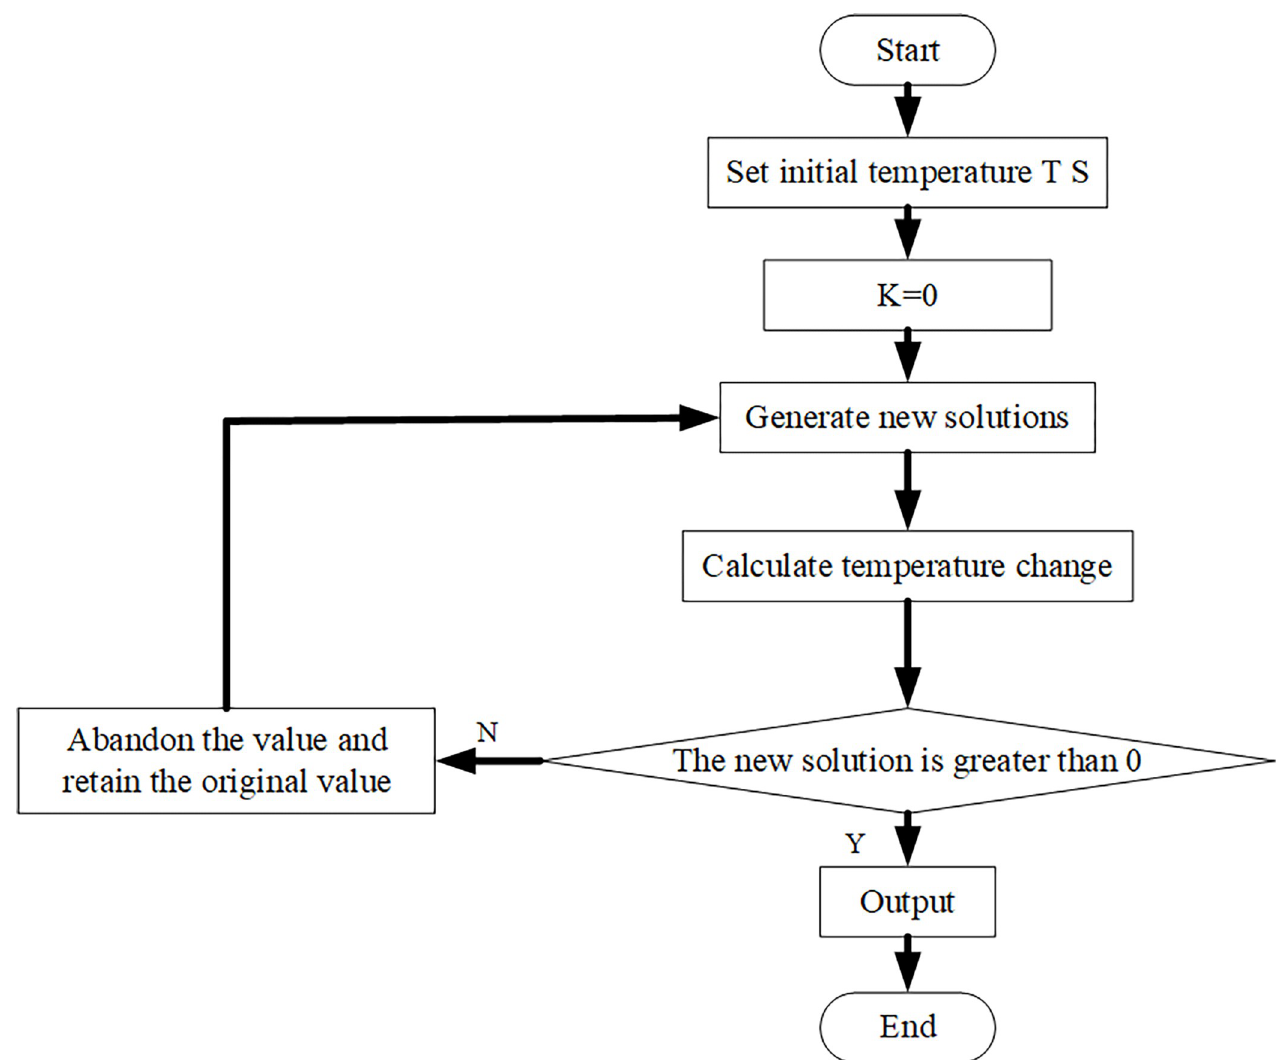
Fig 4. Flowchart of the